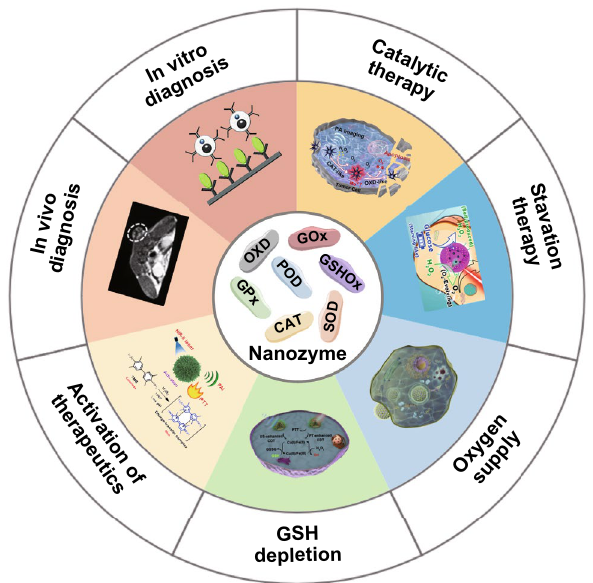
Fig. 1 Schematic illustration indicating the applications of nanozymes in cancer diagnosis in vitro (reproduced with permis- sion from Ref. [33]. Copyright 2013, WILEY–VCH GmbH) and in vivo (reproduced with permission from Ref. [34]. Copyright 2020, WILEY–VCH GmbH), and cancer therapy including catalytic ther- apy (reproduced with permission from Ref. [35]. Copyright 2019, American Chemical Society), starvation therapy (reproduced with permission from Ref. [36]. Copyright 2015, American Chemical Society), GSH depletion (reproduced with permission from Ref. [37]. Copyright 2021, American Chemical Society), oxygen supply (repro- duced with permission from [38]. Copyright 2020, Nature Publishing Group), and activation of therapeutics (reproduced with permission from Ref. [39]. Copyright 2019, American Chemical